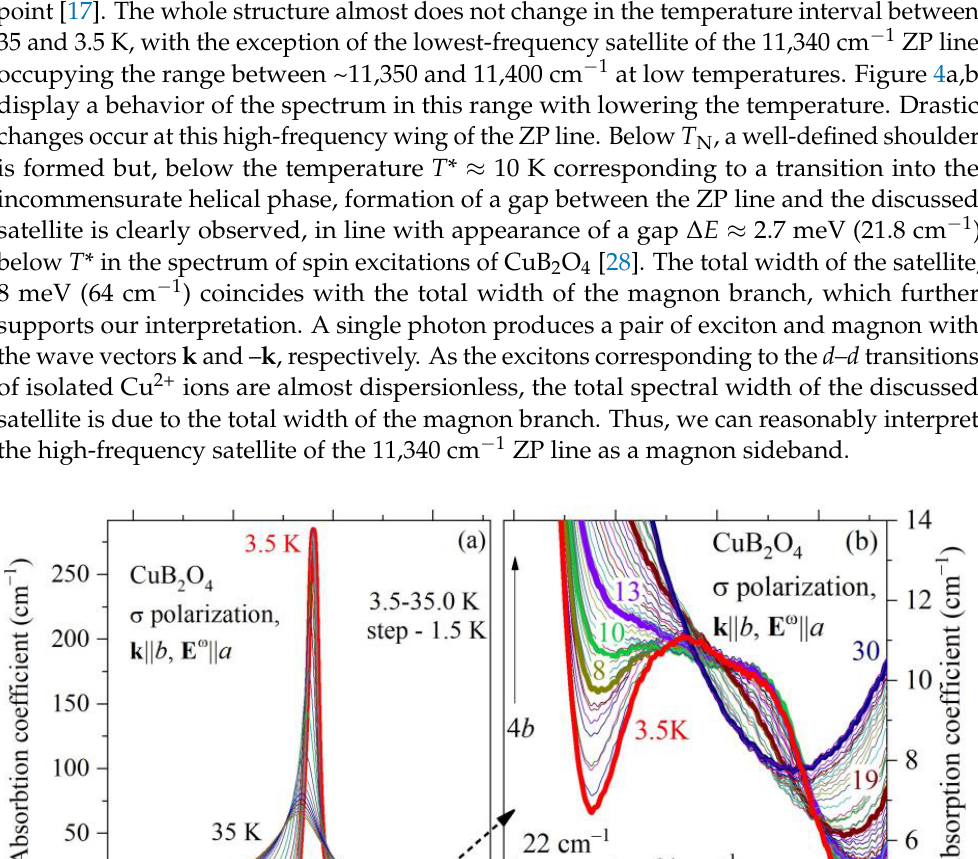
Table 1. Experimental values of integral absorption intensities I j = the exciton spectral line at 1.405 eV for paramagnetic CuB 2 O 4 at T = 25 K in zero external magnetic field, at the α , σ , and π polarizations.